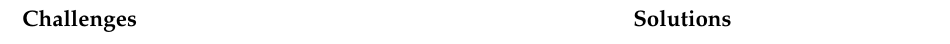
Table 4. Reasoning challenges and